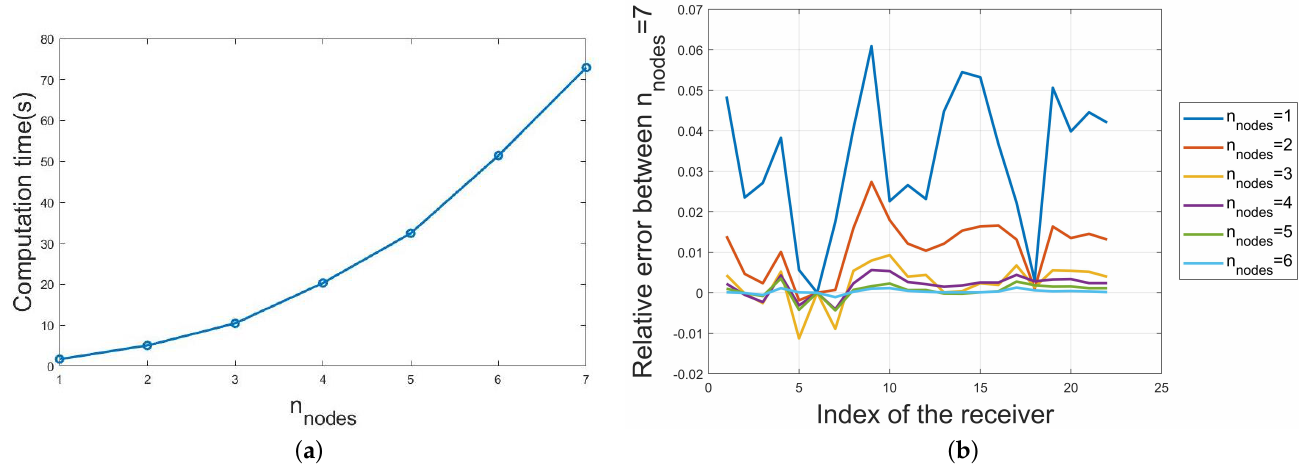
Figure 3. ( a ) Computation time of the forward modeling versus n nodes . ( b ) The relative error of the traveltime data from transmitter No.6. The standard is the traveltime data obtained with n nodes =